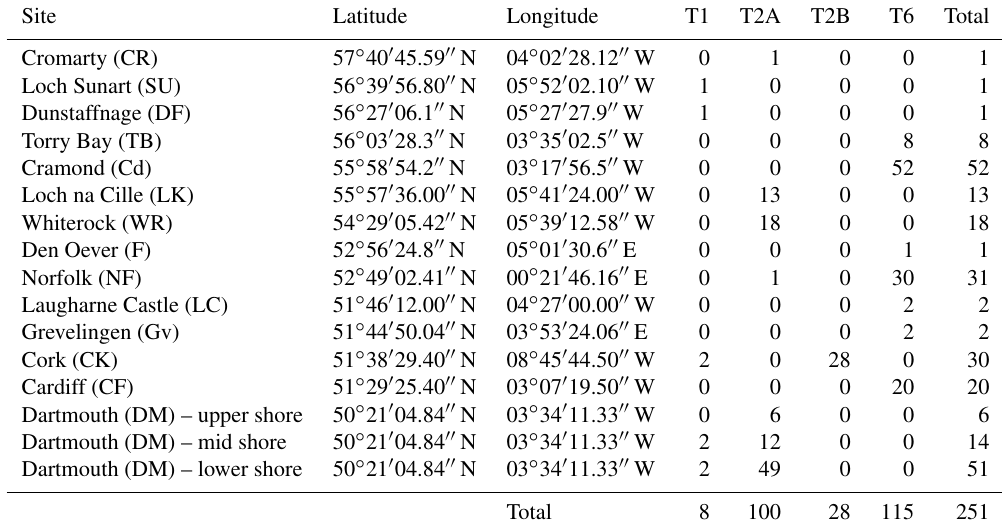
Table 2. Location, geographic coordinates and number of individuals genetically identified as T1, T2A, T2B and T6 for the 16 sites of Bird et al. (2020).